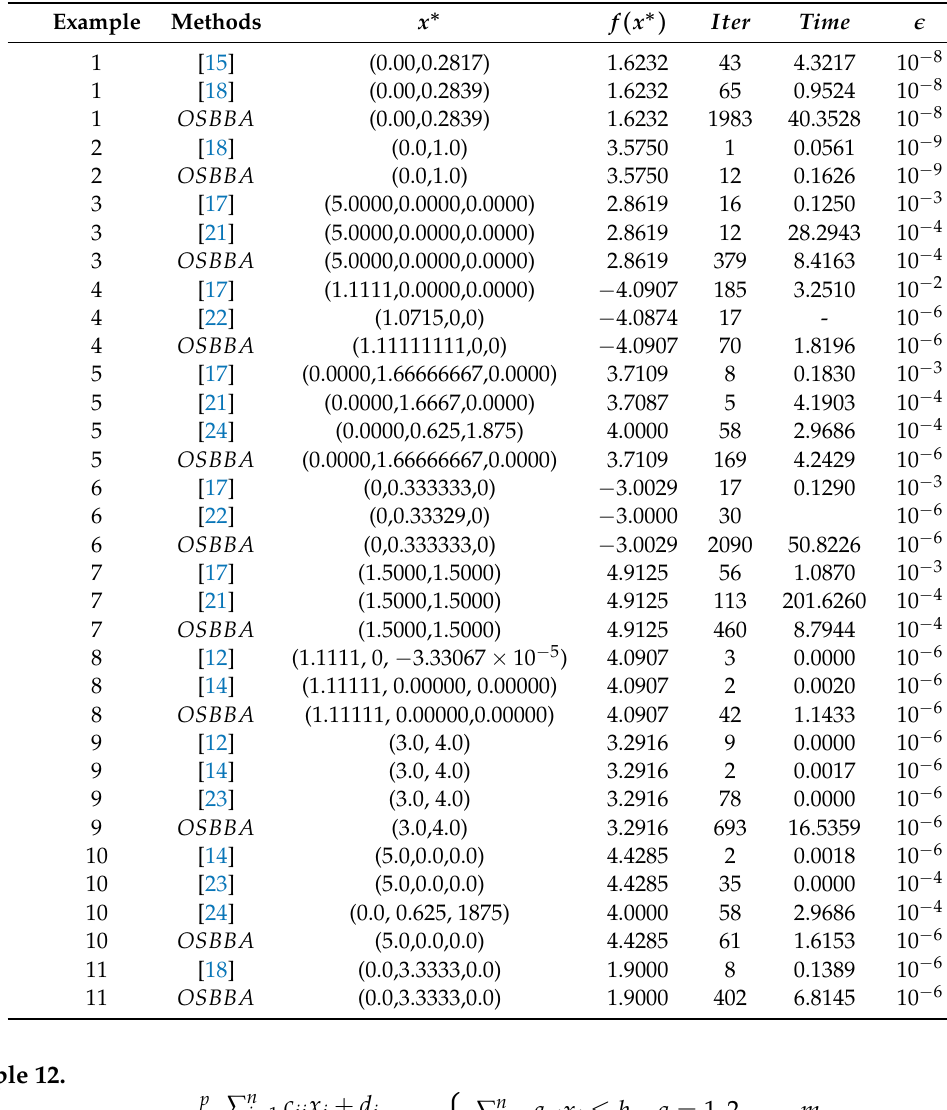
Table 1. Comparison of results in Examples